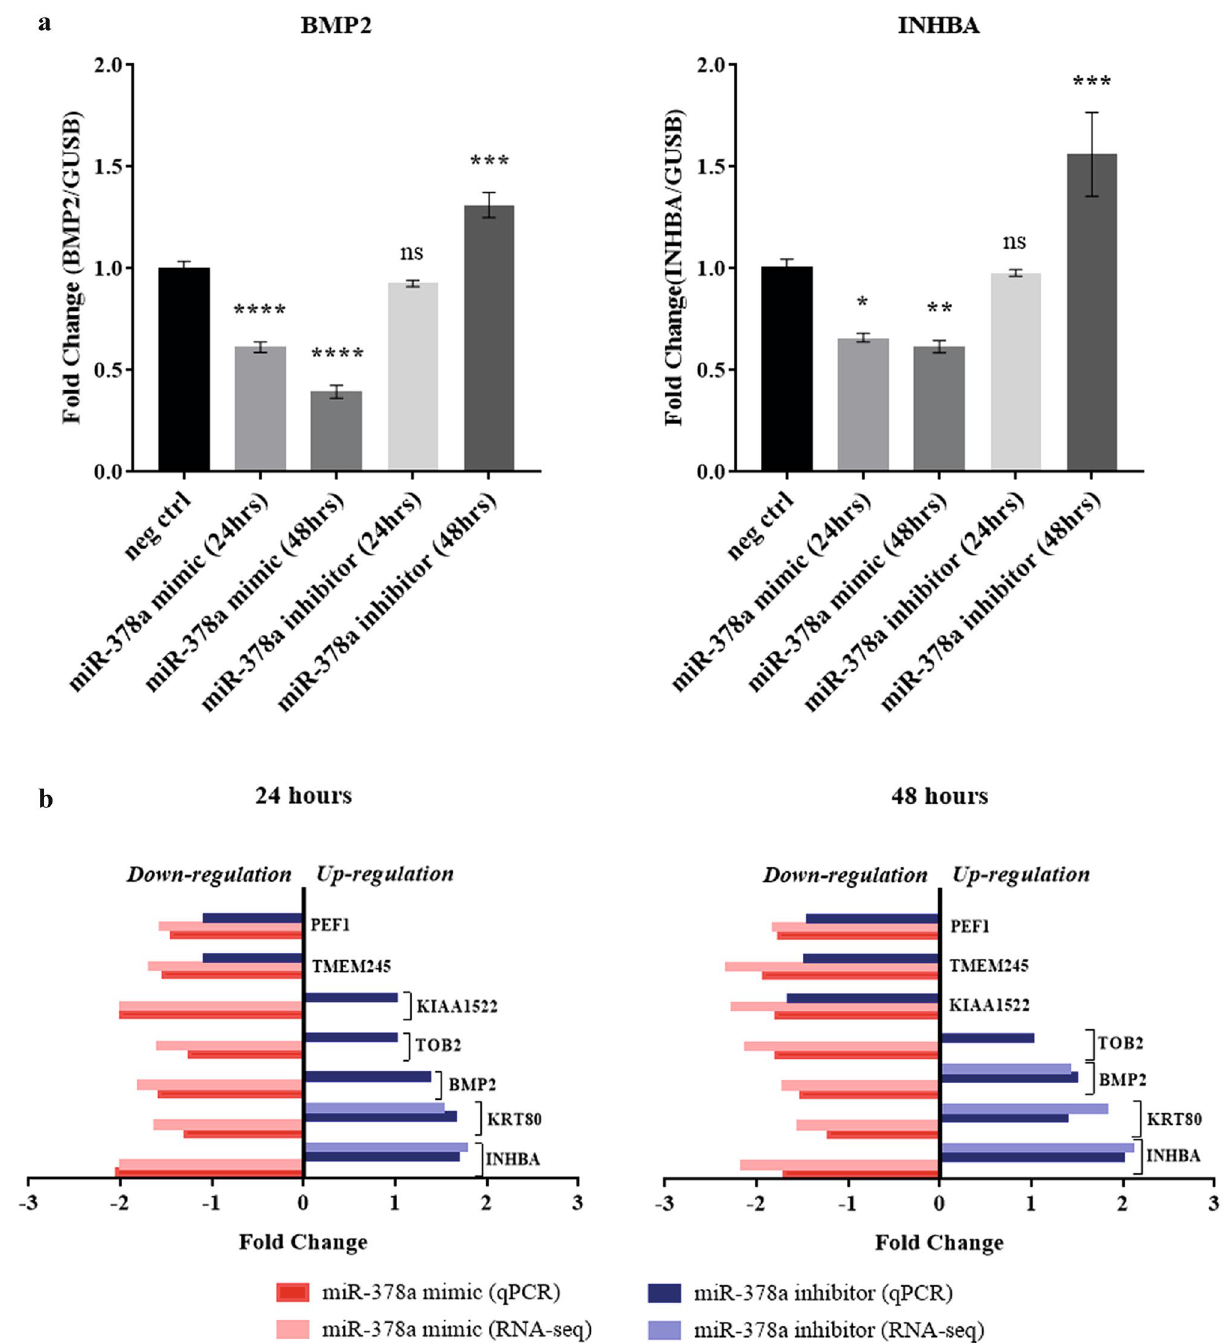
Figure 6. Validation of candidate gene targets of miR-378a. ( a ) The expression levels of BMP2 and INHBA by qPCR using mRNA from NHEK cells transfected with miR-378a mimic or inhibitor for 24 h and 48 h. ( b ) Comparison of the expression levels of the selected candidate genes from high-throughput RNA-sequencing (light colors) versus real-time qPCR (dark colors) from NHEK cells over-expressing miR-378a mimic (red) or inhibitor (blue) for 24 h and 48 h. Error bars indicate mean ± SEM from three replicates. The experiment was performed three times independently. *Indicates P < 0.05, **indicates P < 0.01, and ***indicates P <